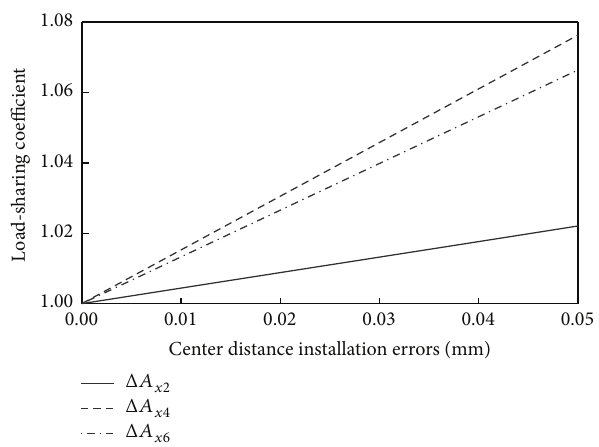
Figure 14: Load-sharing coefficient curves with the change of installation errors.